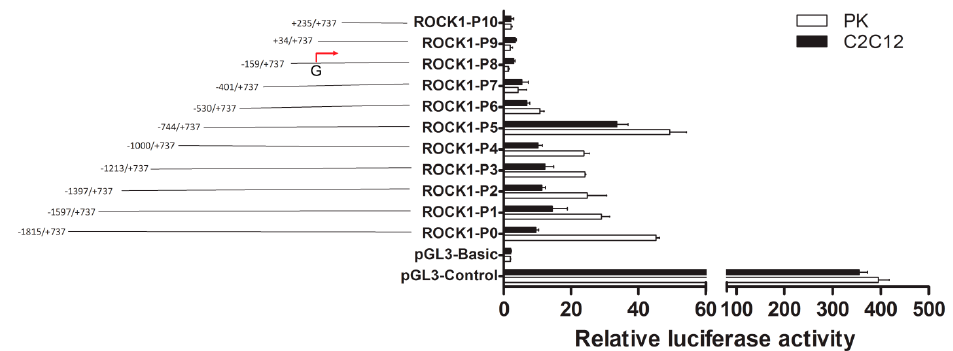
Figure 1. 5’-Deletion analysis of the porcine ROCK1 promoter activity. Schematic representation of the progressive deletions of porcine ROCK1 5’-flanking region in pGL3-Basic vector and the relative activities of ROCK1 promoter corresponding to the progressive deletions. The predicted